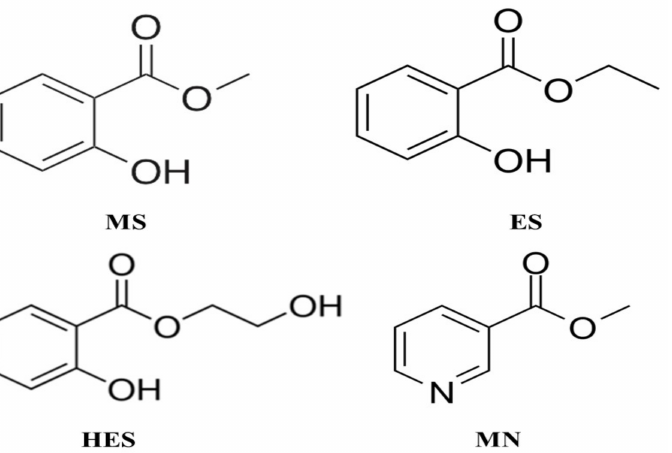
Figure 1. Chemical structures of methyl salicylate (MS), ethyl salicylate (ES), 2-hydroxyethyl salicylate (HES) and methyl nicotinate